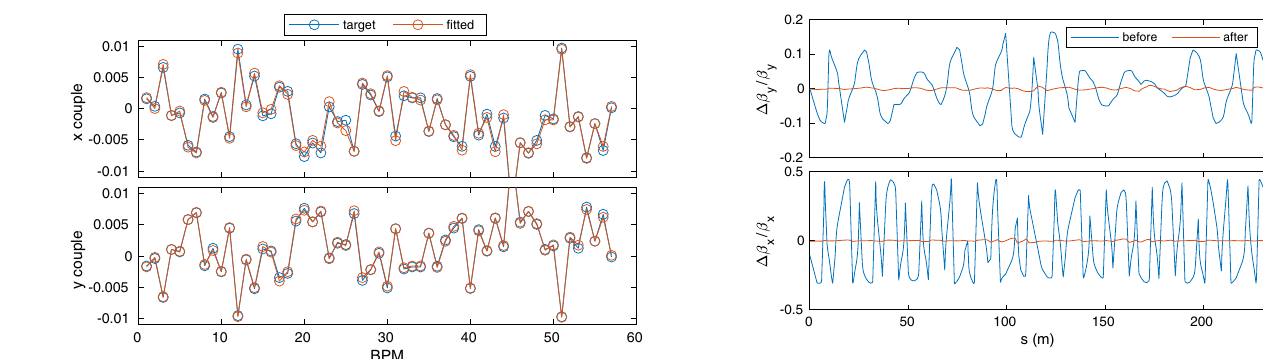
FIG. 9. Beta beating between the reference lattice (with errors) and the ideal lattice ( “ before ” ) is compared to beta beating between the reference lattice and the fitted lattice ( “ after ” ). Top, vertical; bottom, horizontal.